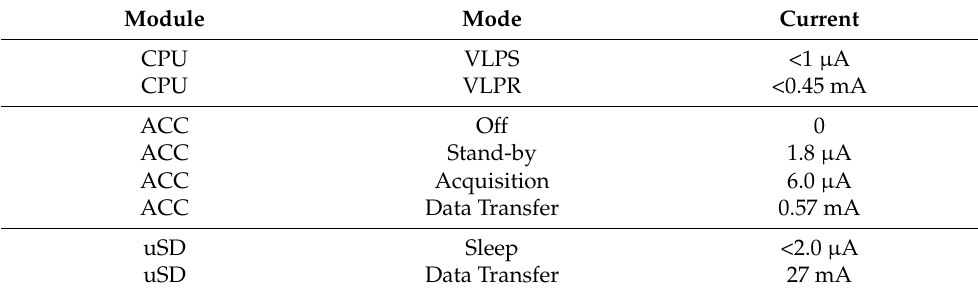
Table 1. The modes and power consumption of the selected devices.